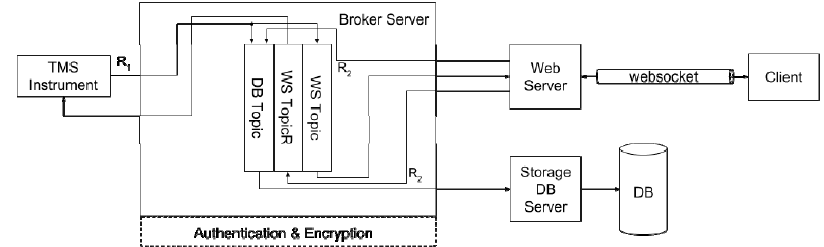
Figure 4. The architecture of the MQTT-based solutions. The Authentication & Encryption tier has to be implemented at higher level since it is not directly managed by the MQTT Broker.